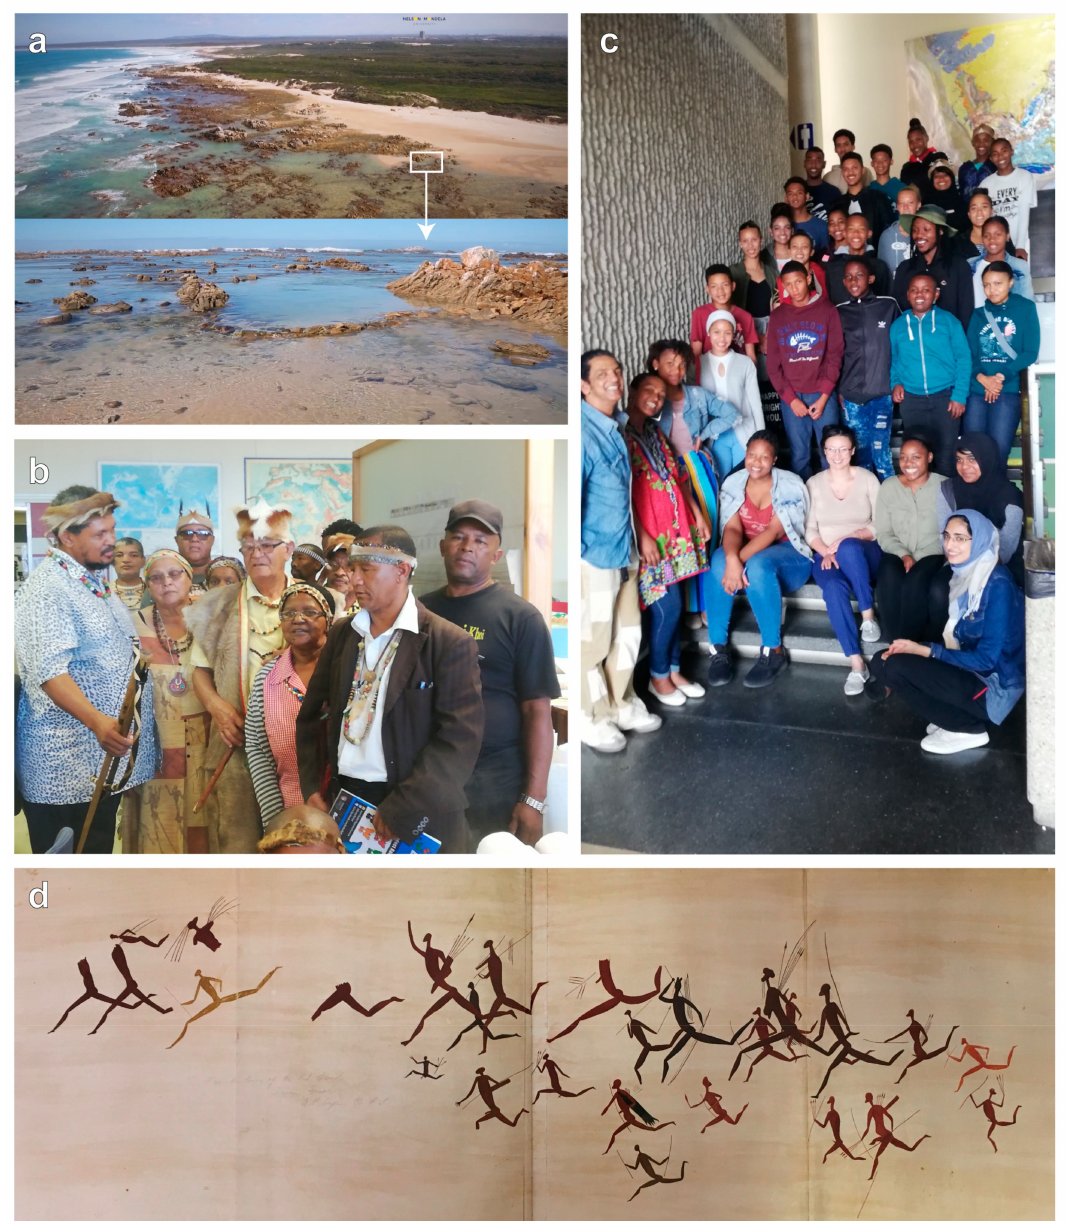
Figure 3. Indigenous Knowledge (IK) documentation through Koi-San research at !Nau-Omkhai ku Dara: ( a ) Fish-traps at Cape Recife nature reserve, some of the earliest human changes to the ecosystem along the coastline (drone data across these traps is shown at “Mandela Talks’ [4]); ( b ) Khoisan chiefs debating their socio-cultural challenges in AEON’s Commons; ( c ) youth engaging in discussions concerning their future career with AEON’s masters and doctorate graduates at Nelson Mandela University; and ( d ) rock painting, copied and first published by geologist George Stow